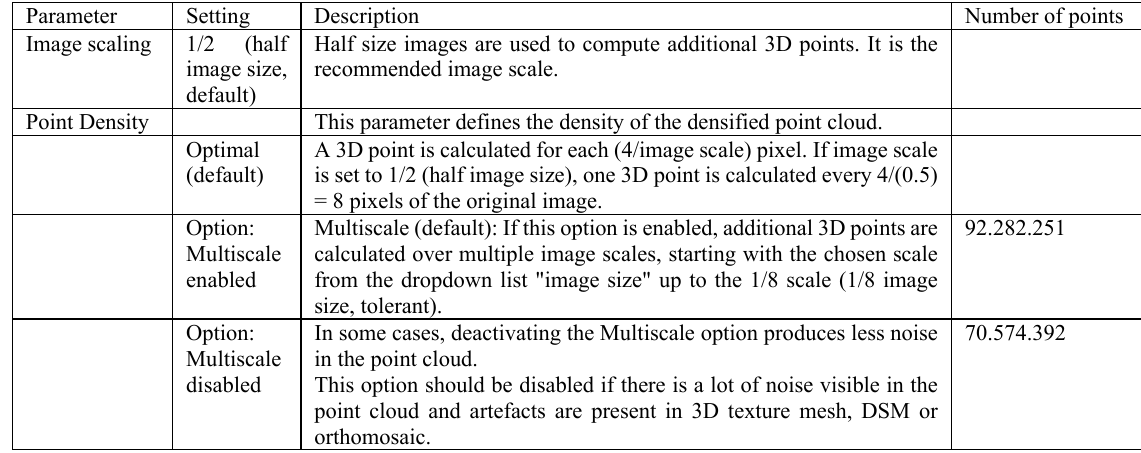
Table 2: Parameterization of the dense point clouds in Pix4Dmapper – as described by the software developer (Pix4D